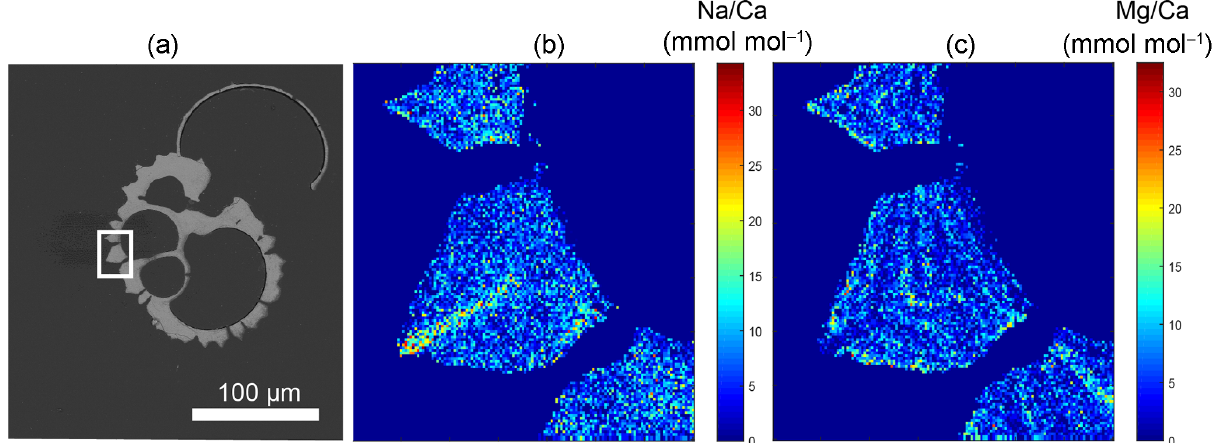
Figure 1. Example of a backscattered electron overview image of an embedded and polished G. ruber plankton tow specimen, with the white square indicating the close-up region (a) , and the Na / Ca (b) and Mg / Ca (c) EPMA images of this close-up showing the relative distribution of both elements within the shell. Whereas Na appears to be mainly concentrated in the spine (base), Mg mainly occurs in clear bands sloping upwards towards the spine and somewhat lower in the spine region (Mezger et al., 2018).